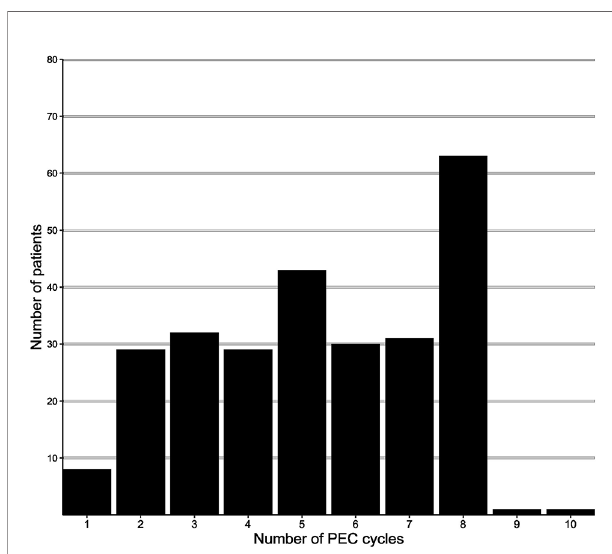
FIGURE 2 | Distribution of PEC